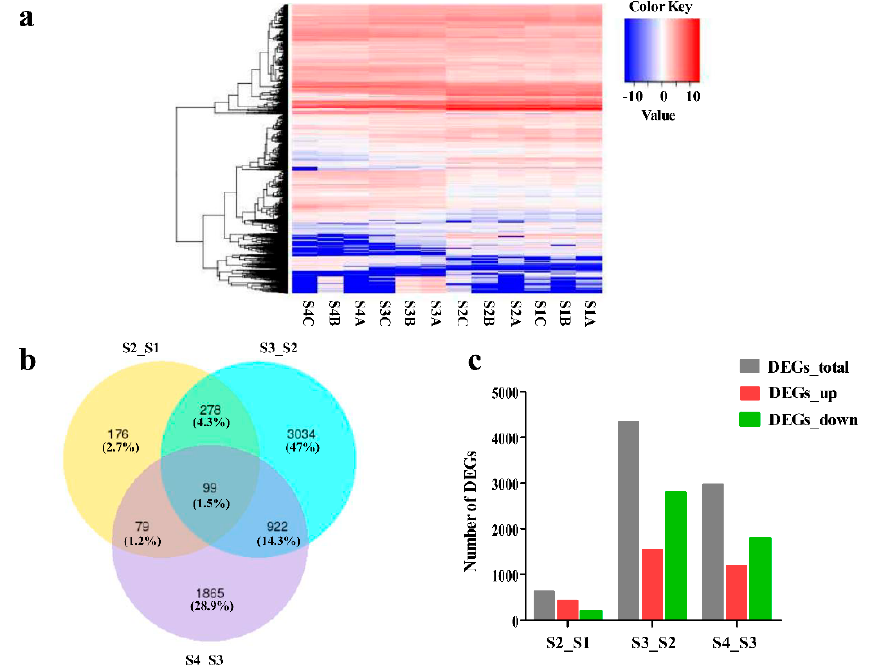
Figure 3. Analysis of transcriptomic data. ( a ) Heat map of DEGs in different developmental stages of Cerasus humilis fruit peel; ( b ) Venn diagram of DEGs revealed in pair-wise comparisons; ( c ) The number of DEGs in pair-wise comparisons, |log2 Ratio| ≥ 1 and q < 0.05. Young fruit (S1), 30 days post-anthesis (DPA), green fruit (S2), 42 days post-anthesis (DPA), slightly red fruit (S3), 57 days post-anthesis (DPA), and red fruit (S4), 70 days post-anthesis (DPA). A, B, and C are three biological replicates.